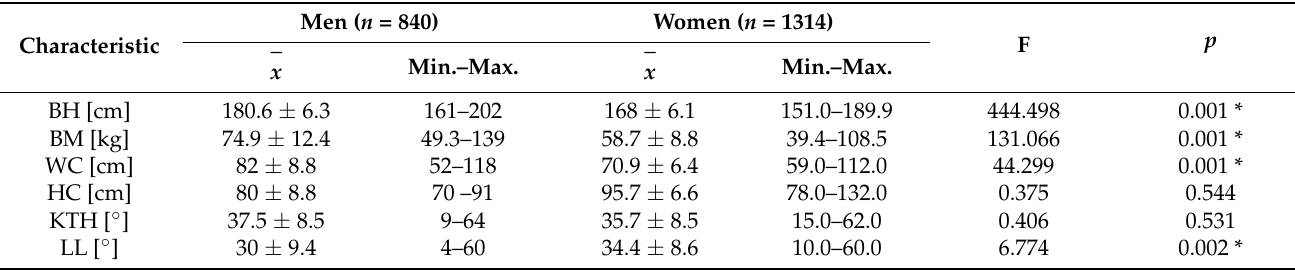
Table 2. Significant gender differences in the analysed characteristics of body build and posture between women and men in 2006–2016.